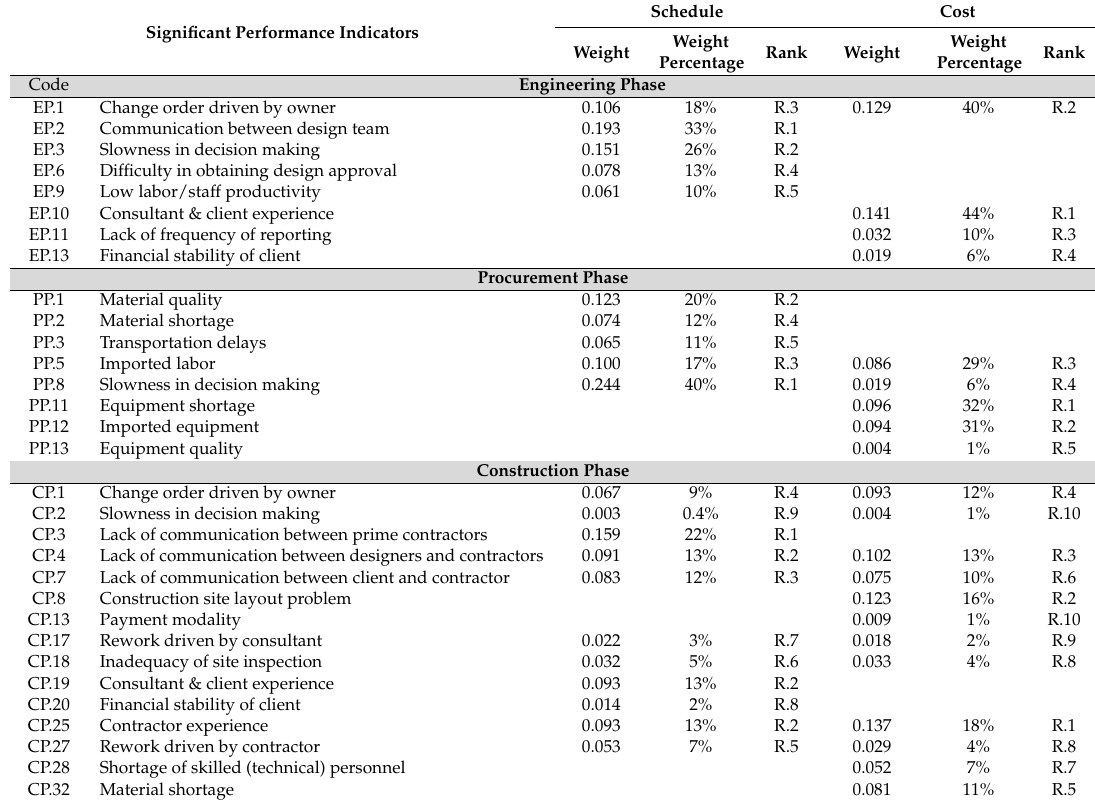
Table 6. Ranking of Phase-Based Cost and Schedule Key Performance